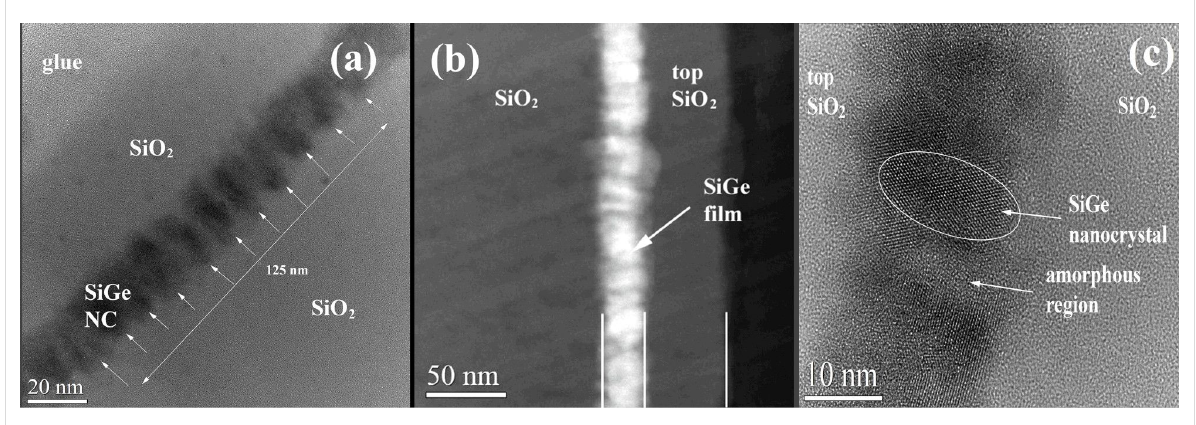
Figure 5: (a) XTEM image of MLs annealed at 600 °C (1 min) showing columnar morphology of SiGe NCs in the film. The crystallites have a period- icity of ≈ 12.5 nm. (b) STEM-HAADF image. (c) HRTEM image with SiGe NCs separated by amorphous regions (with SiGeO).